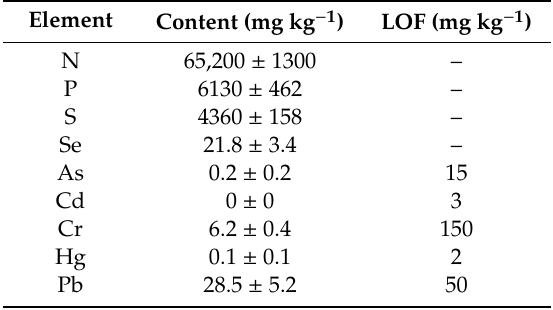
Table 4. Contents of elements in algal-bacterial biofilm harvested from the bioremediation